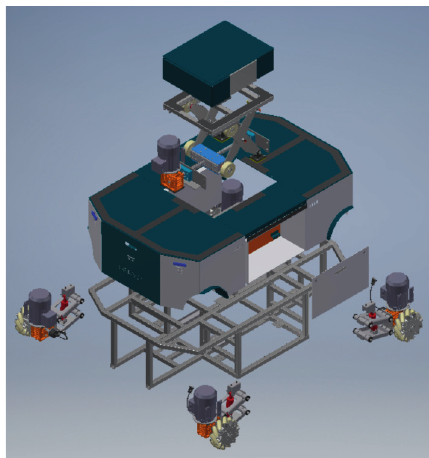
Figure 6: Exploded view of the AGV principal